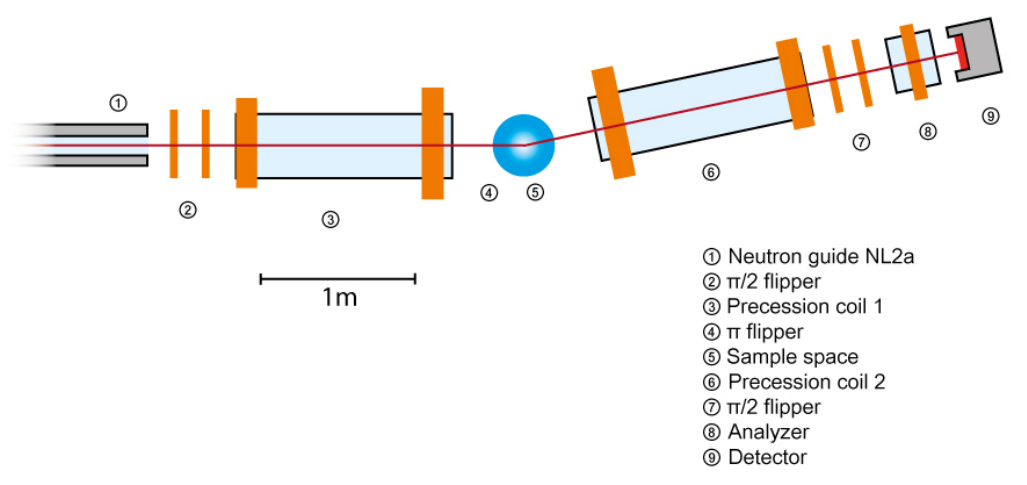
Figure 2: Schematic drawing of J-NSE set-up, top